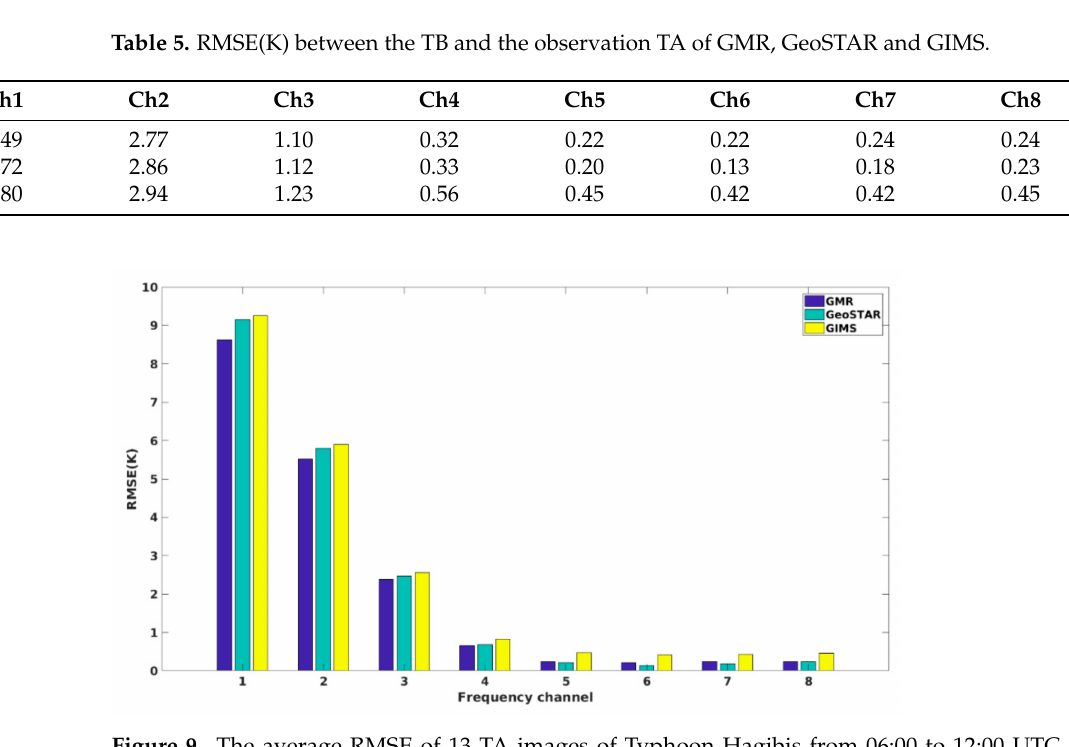
Figure 9. The average RMSE of 13 TA images of Typhoon Hagibis from 06:00 to 12:00 UTC on 8 October